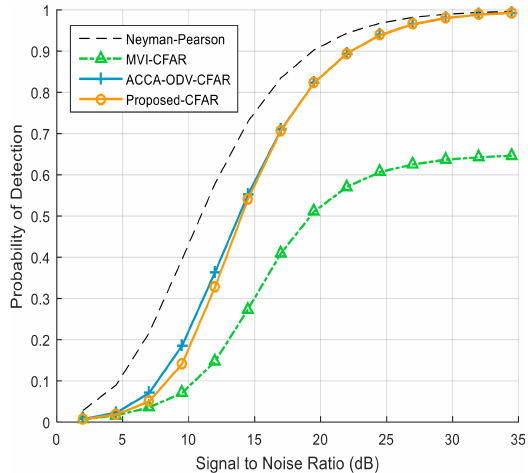
Figure 8. Detection probability on both sides of reference window and the number of interfering targets on both sides of reference window are the same ( N = 36, P fa = 10 − 4 ).